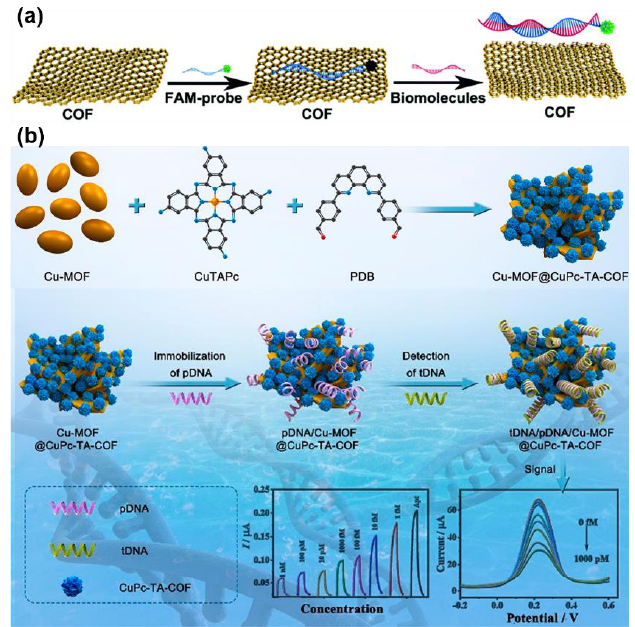
Figure 14. ( a ) A versatile COF-based platform for sensing DNA [171]. Copyright 2017 Royal Society Figure 12. ( a ) COF − 300 − AR for GSH detection [26]. Copyright 2020 American Chemical Society; of Chemistry; ( b ) MOF@ COF Heterostructure Hybrid for Dual- Mode Photoelectrochemical−Elec- ( b ) Py − TT COF for GSH sensing [27]. Copyright 2021 American Chemical trochemical HIV-1 DNA Sensing [173]. Copyright 2021 American Chemical Society. Table 9. COF-based sensing of some typical biomacromolecules.